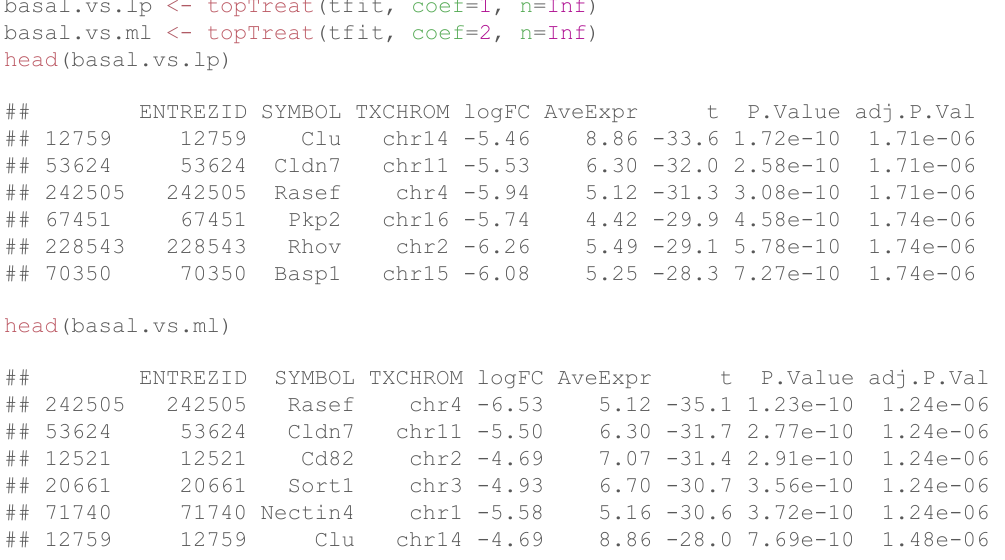
Examining individual DE genes from top to bottom The top DE genes can be listed using for results using (or for results using topTreat treat topTable ). By default arranges genes from smallest to largest adjusted p -value with associated gene eBayes topTreat information, log-FC, average log-CPM, moderated t -statistic, raw and adjusted p -value for each gene. The number of top genes displayed can be specified, where includes all genes. Genes Cldn7 and Rasef are amongst the n=Inf top DE genes for both basal versus LP and basal versus ML.